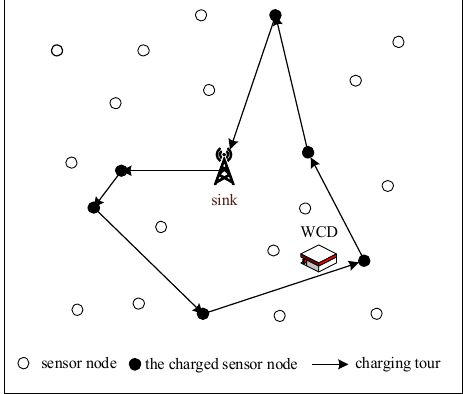
Figure 1. The rechargeable wireless sensor network.